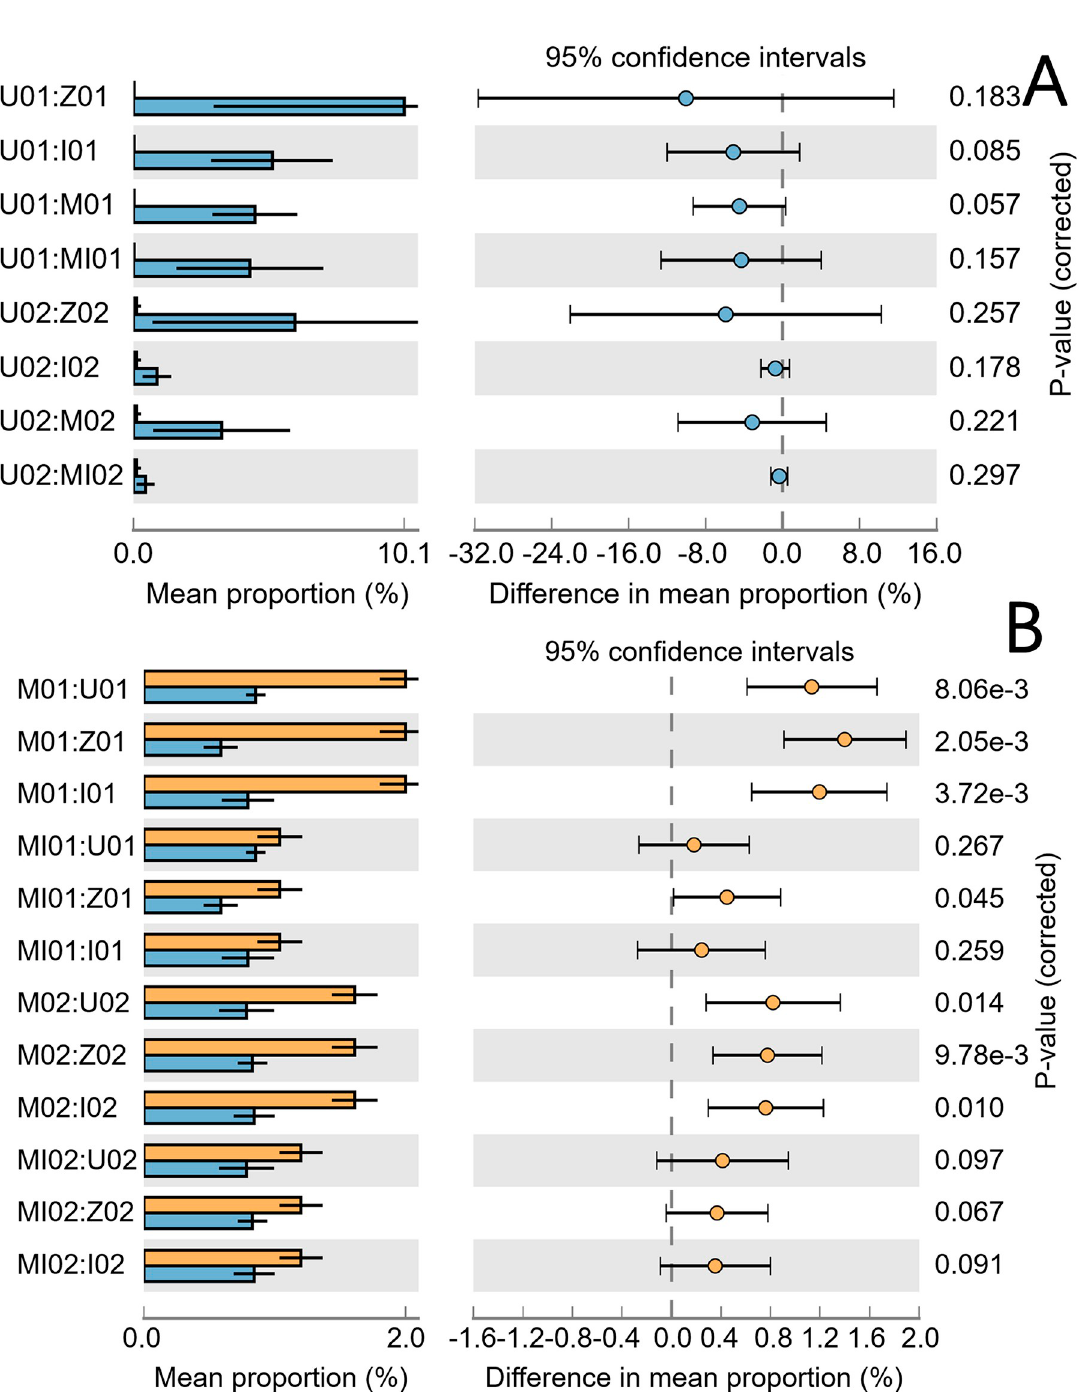
Fig 5. Inter-group difference test of microorganism relative abundance. Mrakia frigida (A), Betaproteobacteriales (B).